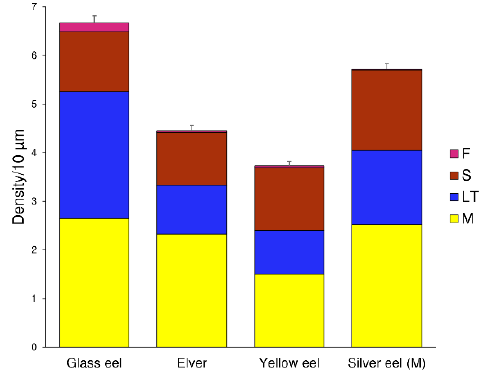
Figure 6. Dendritic spine density per 10 µ m of dendritic trunk length ± SEM, grouped for eels’ life stage and for spine class. Bars are repartitioned according to the life stage of eels and the dendritic spine class, respectively (M: mushroom in yellow, LT: long thin in blue, S: stubby in red, F: filopodia in pink). Table 2. Summary of K-W test among eels’ life stages. Paired post hoc Dunn’s test between dendritic spine classes. p values < 0.05 are significant. Asterisks indicate the significance code: p < 0.0001 =